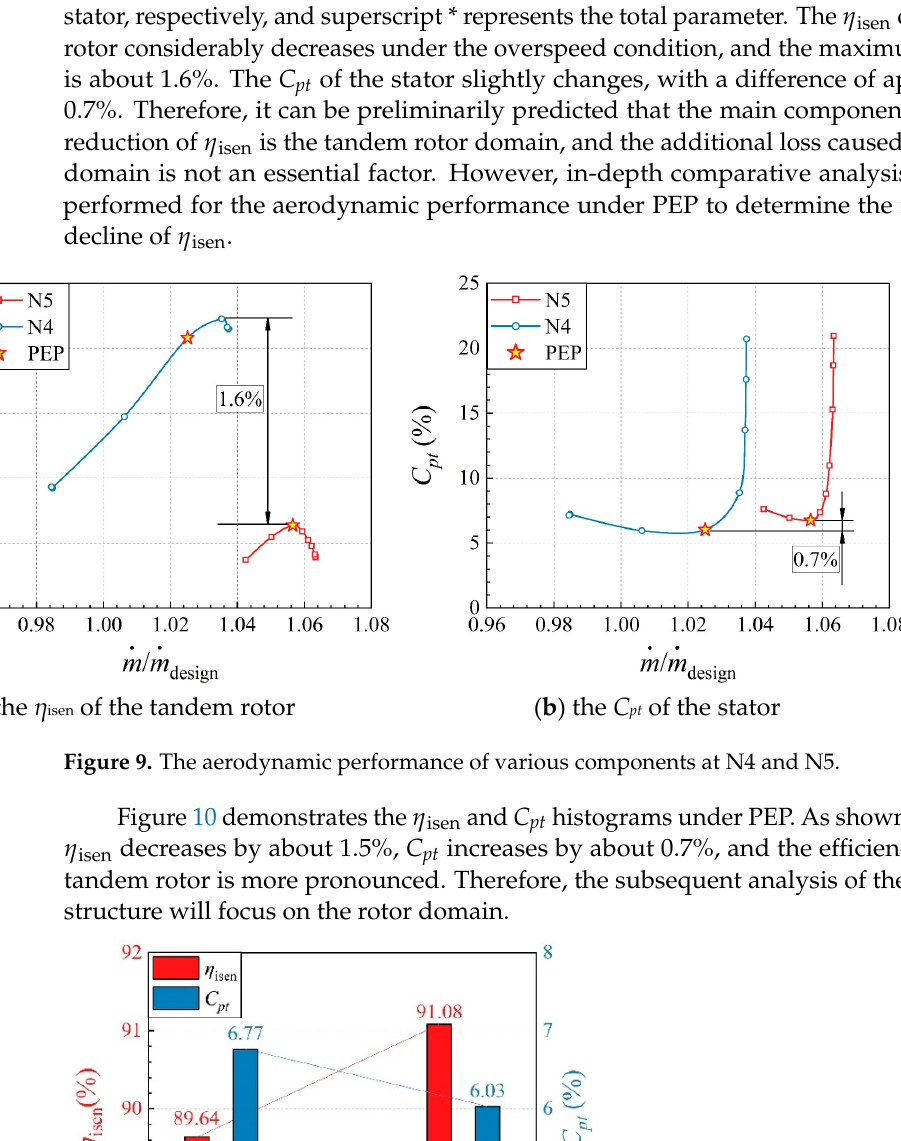
Figure 8. Relative change trend of m (cid:4662) choke , π , and η isen for the high-throughflow fan stage under dif- ferent rotating speeds.